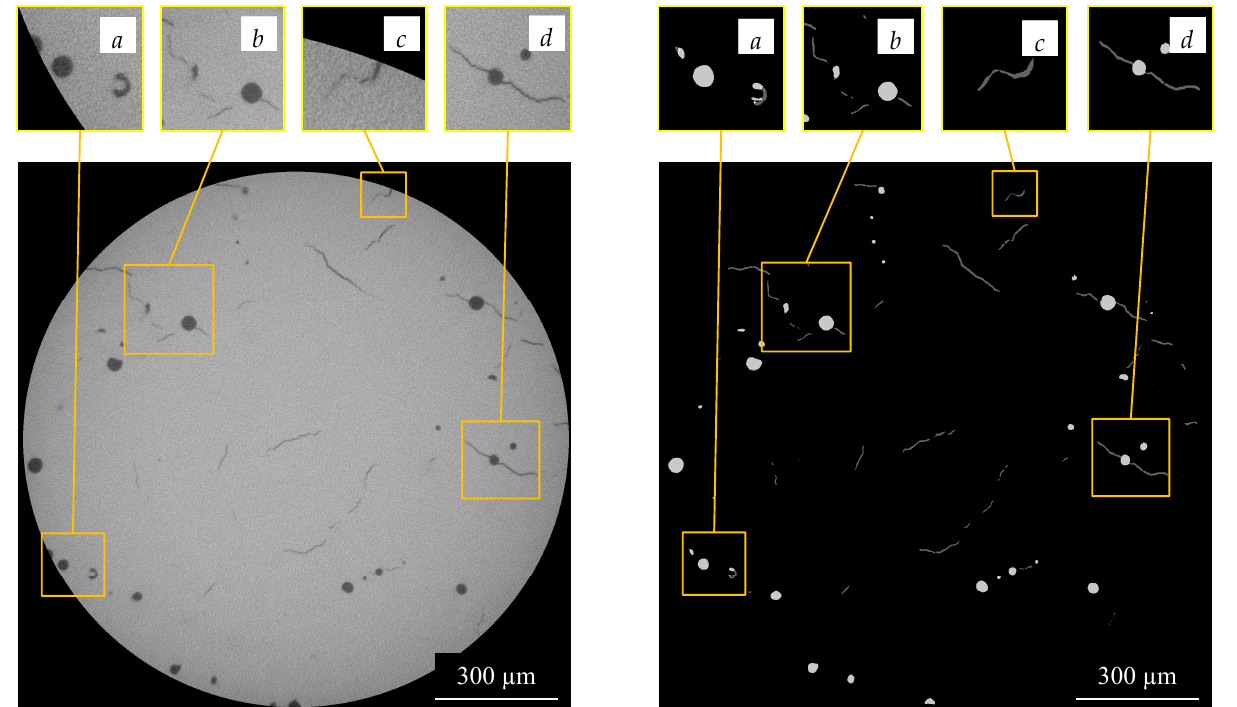
Figure 14. Segmentation performance of the network for a new slice of tomography dataset. ( left ): original image, ( right ): segmented map by AI generated in about 2.3 s. ( a ) detecting pores intersected with background and non-circular pores, ( b ) detecting a cluster of pores and cracks ( c ) detecting a crack intersected with background ( d ) detecting connected pores and